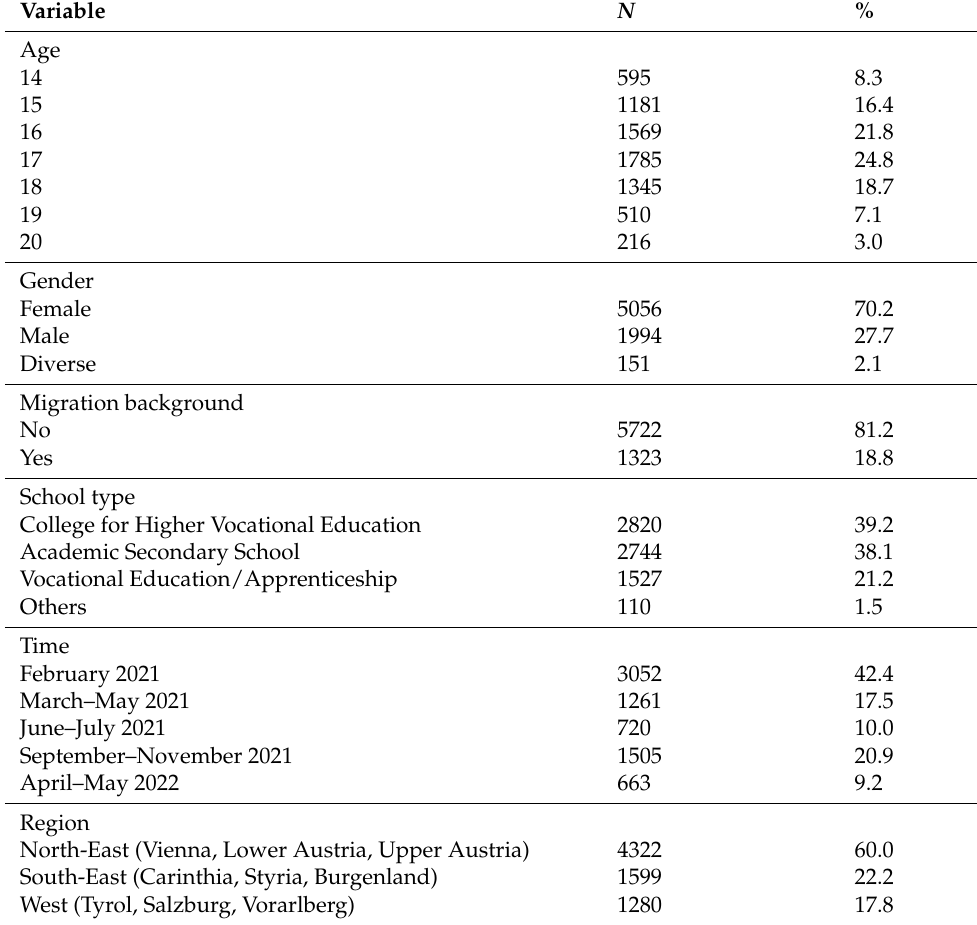
Table 1. Study sample characteristics ( N =